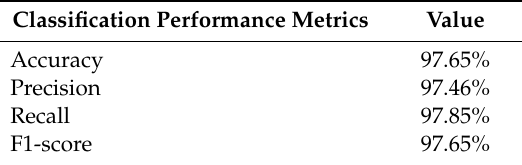
Figure 14. Top 10 features of Linux binary. Table 11. Classification Performance of Linux Binary.